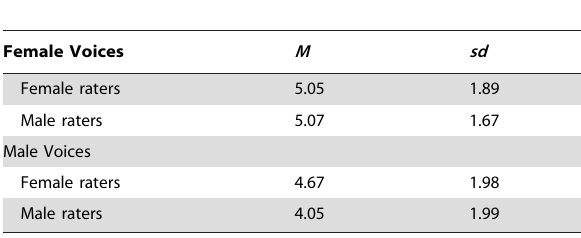
Table 6. Means and standard deviations for male and female voices and male and female